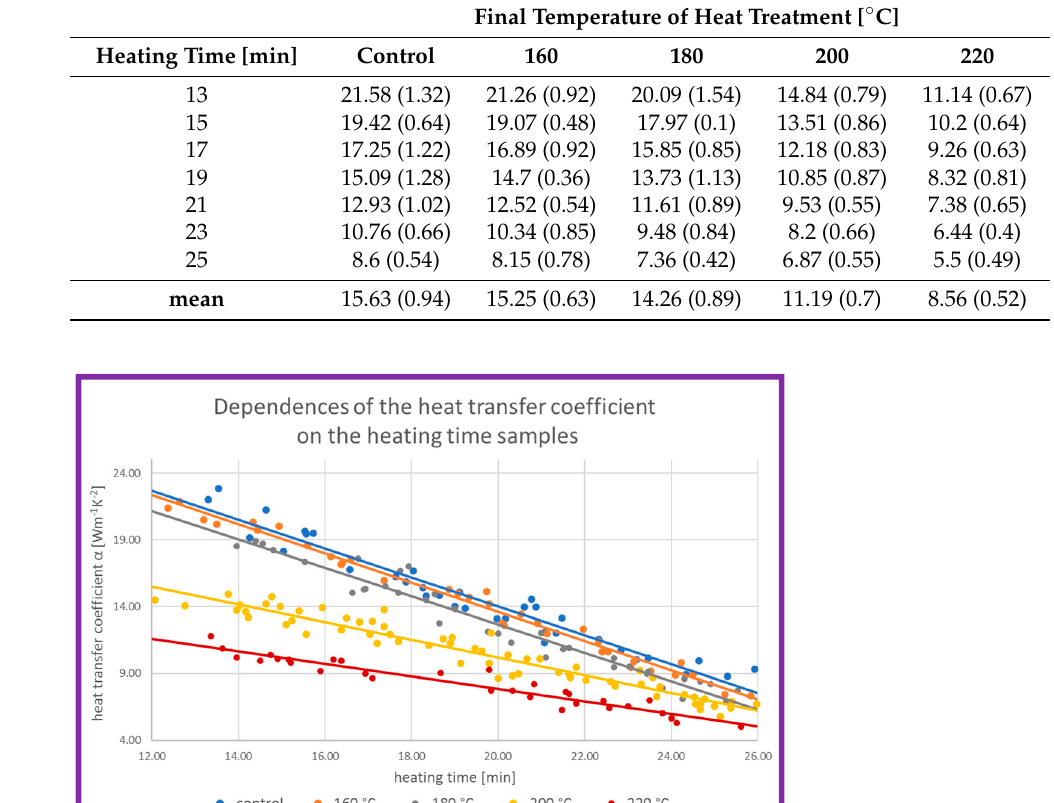
Figure 5. Evaluation of the temperature profile above the sample (spruce treated at 180 °C, surface temperature 55 °C). ( a ) Evaluated interferogram where section lines (S 1 –S 5 ) are shown indicating the position where interferograms were evaluated. ( b ) Locations of the interference fringes (y0; y1; y2) and the surface of the heated sample (x0) in the S 1 section. Table 2. Calculated values of the heat transfer coefficient α . Results are means (standard deviation).